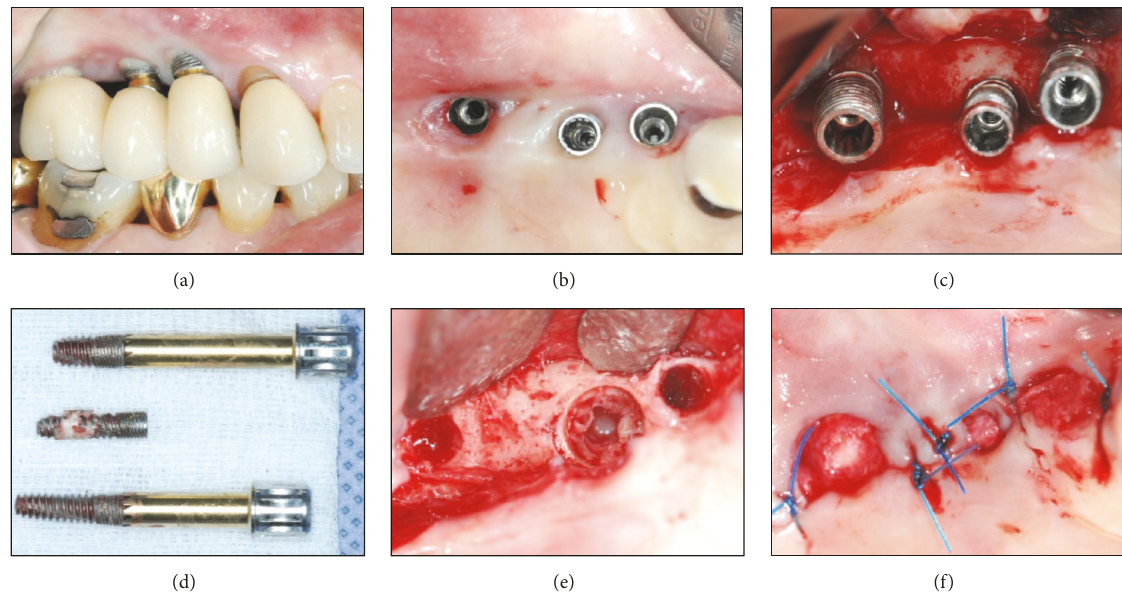
Figure 6: Advanced and mixed removal methods applied on #14, #15, and #16 regions. (a) Supragingival eruption state of an implant fixture. (b) Implant prosthodontics removal state showing a lack of keratinized gingiva and peri-implant tissue impairment. (c) Exposure of upper portionoftheimplantfixtureandseveresurroundingalveolarboneloss.(d)ImplantremovalusingtheNeoFRKit(NeoBiotech,Seoul,Korea) on #14 and #16 regions and using the trephine bur (external diameter: 5 mm, internal diameter: 4mm) on #15 region and the surrounding alveolar bone. (e) Implant removal socket showing a perforation of the sinus inferior wall and maintenance of the internal schneiderian membrane. (f) Tension-free suture for a natural healing progress.